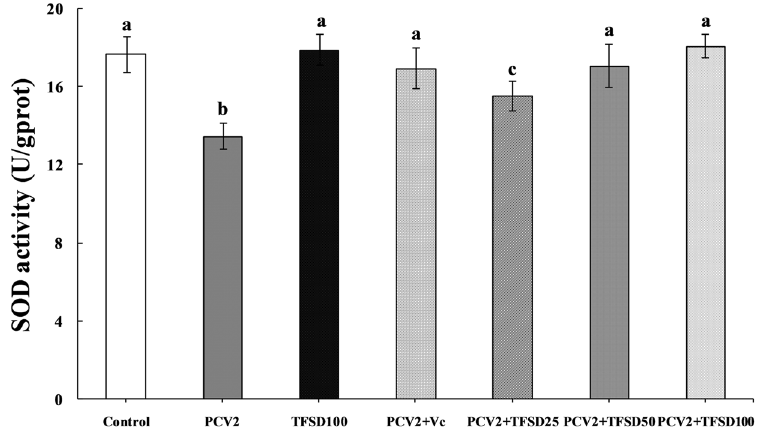
Figure 6. Effect of TFSD on SOD activities in the spleen of PCV2 infected mice. Data are presented as mean ± SD (n = 10). Bars with different letters are statistically different ( P < 0.05).